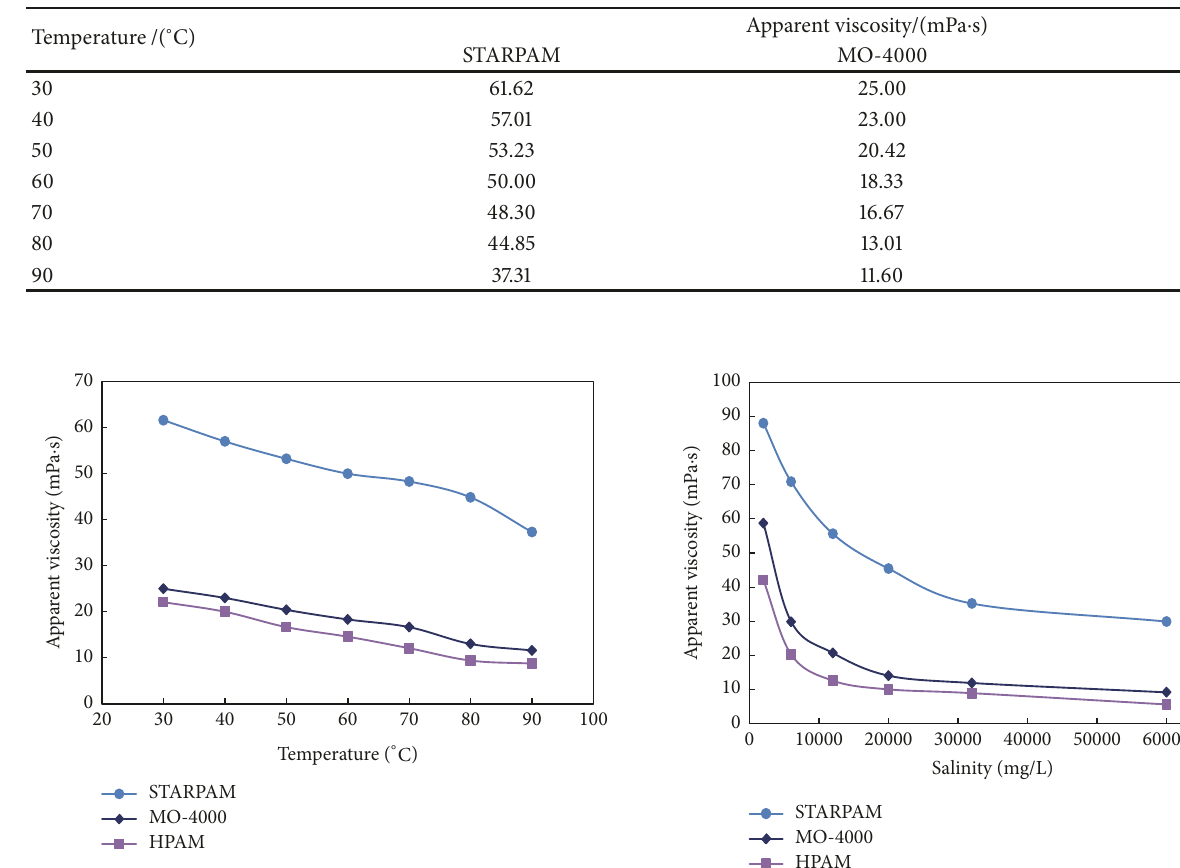
Table 3: Comparison of heat resistance.